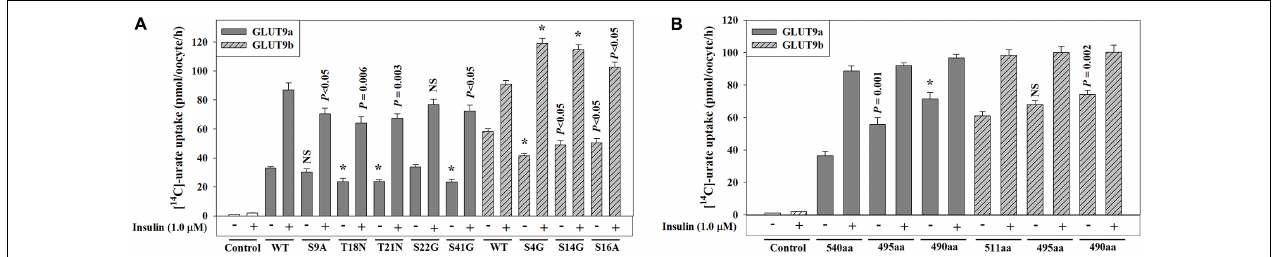
FIGURE 6 | The N-terminal domain of human GLUT9 isoforms play a significant role in functional activation of by insulin. (A,B) The [ 14 C]-urate uptake mediated by GLUT9a/GLUT9b, and its N-terminal point mutants (A) or its N-terminal deletion mutants (B) was examined in oocytes in the absence and presence of 1.0 µ M insulin in K + -free isotonic medium (pH 7.4) at ∼ 25 ◦ C. Asterisk (*), P < 0.001 compared with the urate uptake by the normal urate transporter in the absence/presence of